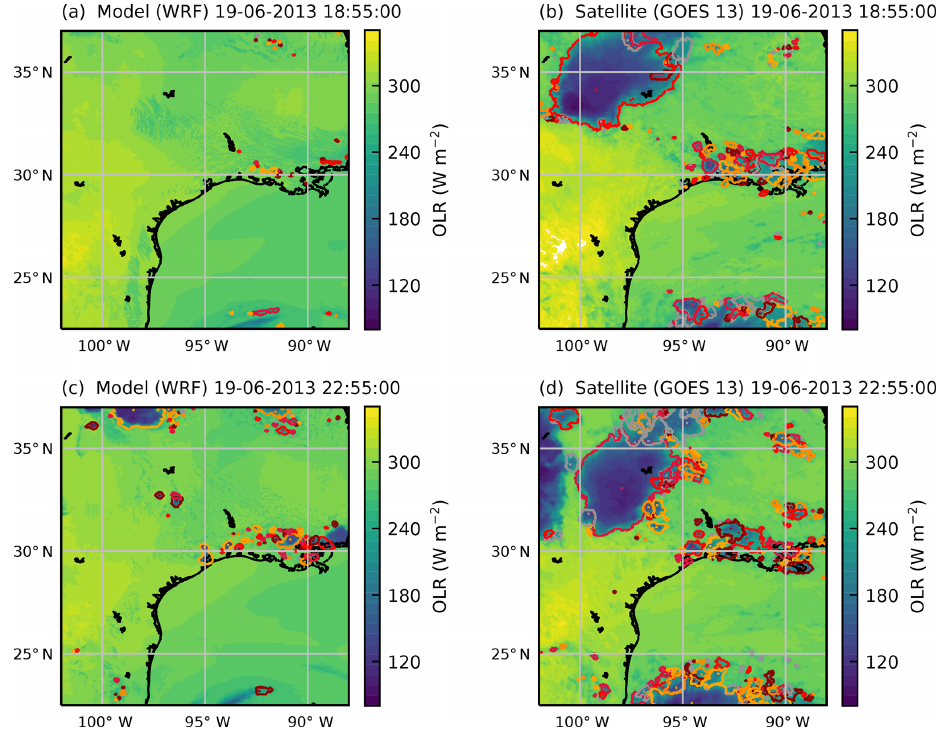
Figure 9. Identified and tracked objects at two specific points in time (19 June 2013 at 18:55 and 22:55UTC) based on outgoing longwave radiation for the WRF simulations with 4.5km grid spacing (a, c) and the outgoing longwave radiation derived from the combination of two GOES-13 channels following Singh et al. (2007) (b, d)